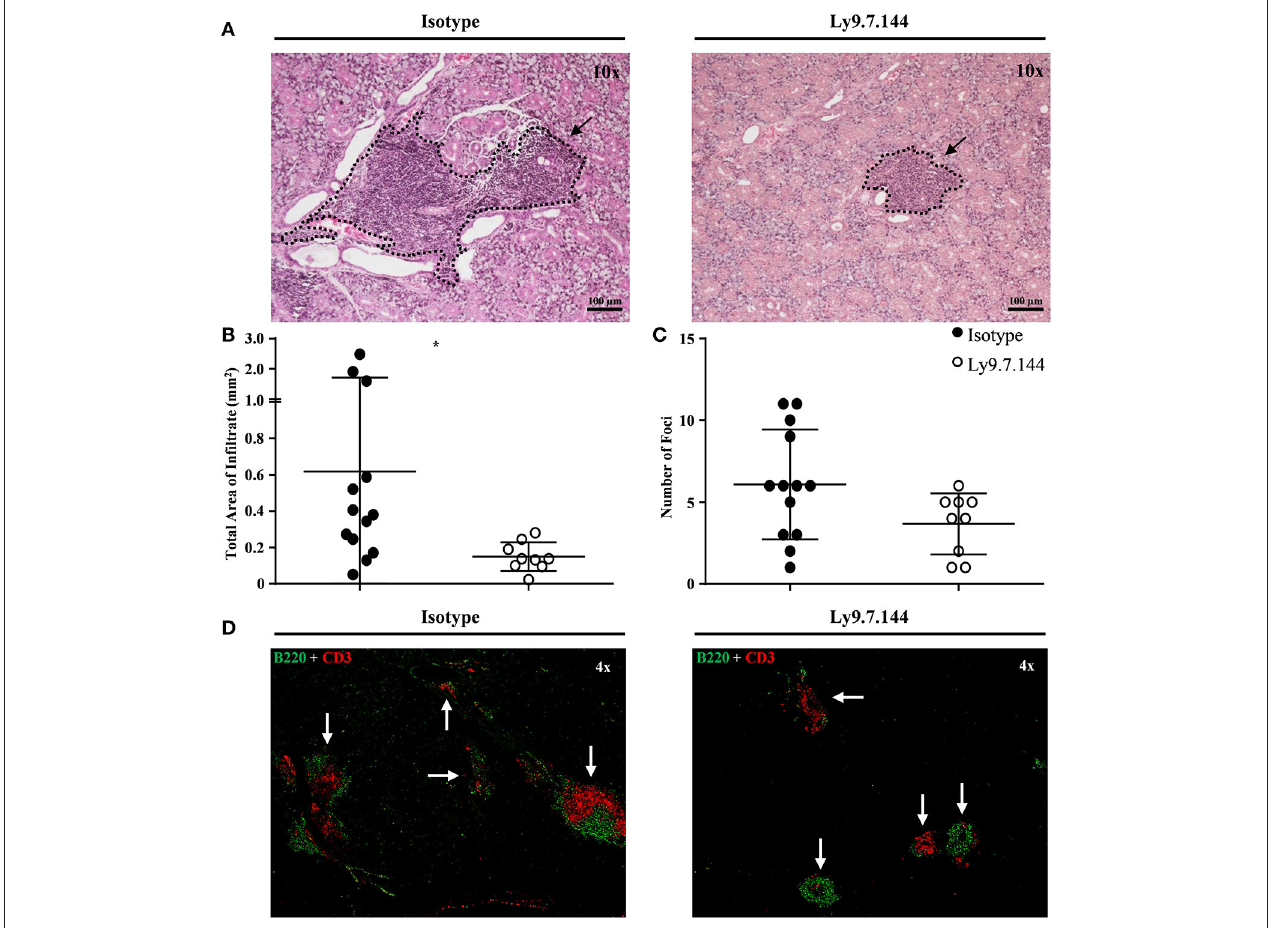
FIGURE 3 | Mice receiving Ly9.7.144 show a reduction in lymphocyte infiltrates area in the inflamed salivary glands of SjS mice. Representative foci from isotype control (left) or anti-Ly9 (right) treated NOD.H-2 h4 mice found in H&E and immunofluorescence (B220 is shown in green and CD3 in red) staining are shown (A,D) . Total area of infiltrating cells (B) and foci number (C) were calculated from H&E staining of salivary gland paraffin-embedded tissue sections. Three consecutive tissue sections were analyzed per mice to determine foci number. Dotted lines contouring infiltrating areas are indicated with black arrows. The foci was defined as the presence of > 50 infiltrating leukocytes in continuum space. Results are expressed as mean ± SD. * p < 0.05 (unpaired two-tailed t -test). Data are pooled from four independent experiments.